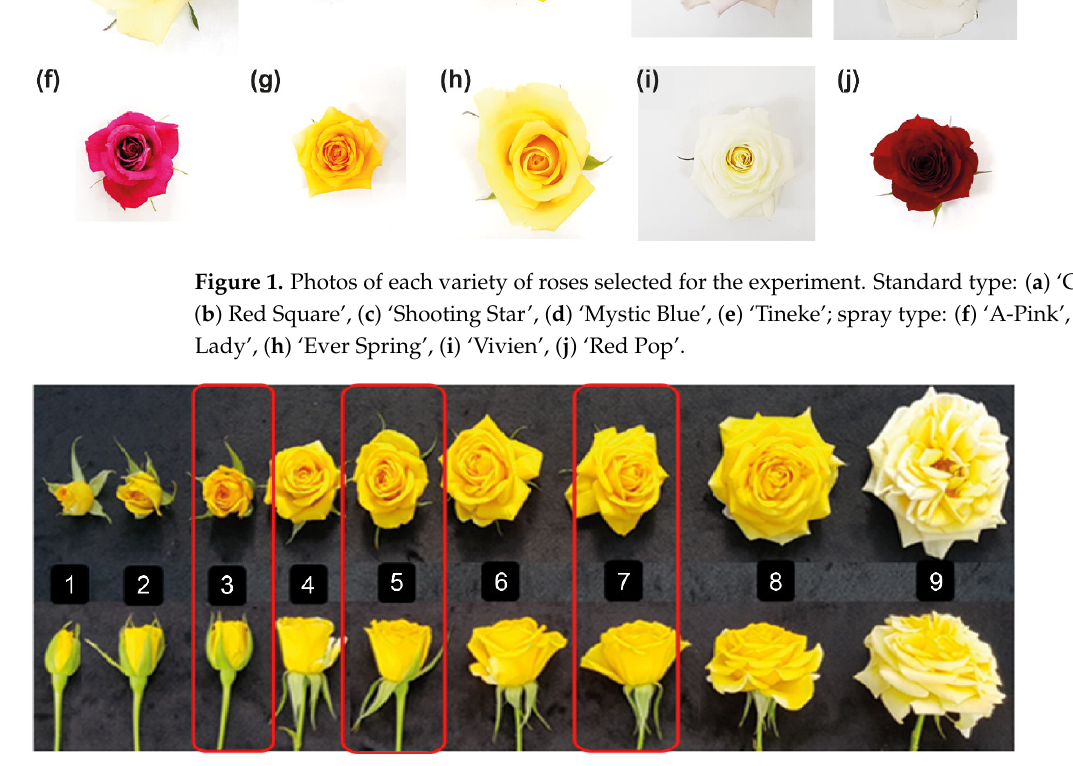
Figure 2. Flower development stages (1–9) of the ‘Shooting Star’ rose variety.